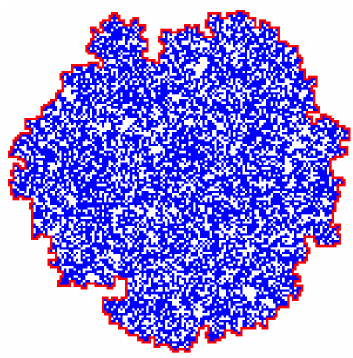
Figure 1. A region with both short-range and long-range infections.